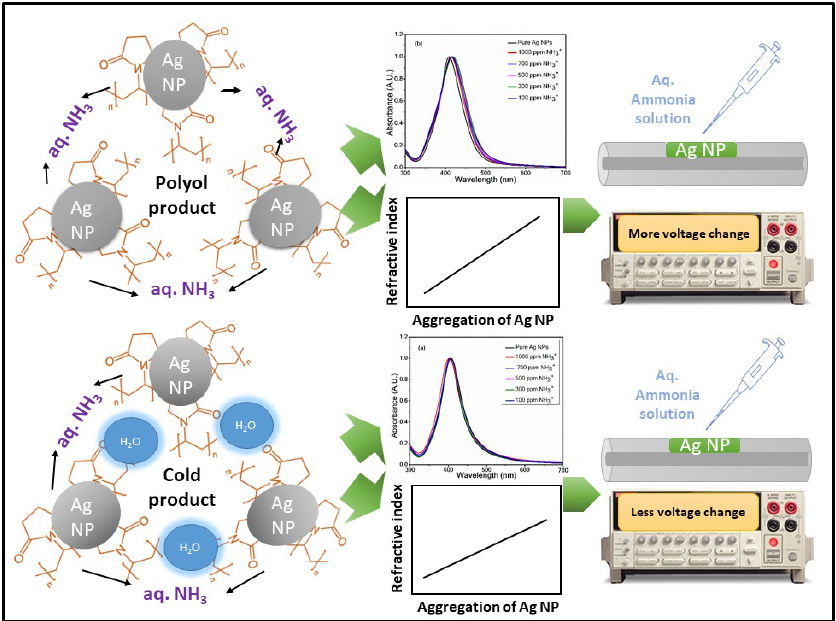
Figure 10. The sensing mechanism of: ( a ) cold synthesis method produced PVP capped Ag-NPs coated optical fiber-based ammonium sensor, and ( b ) polyol synthesis method produced PVP capped Ag-NPs coated optical fiber-based ammonium sensor.